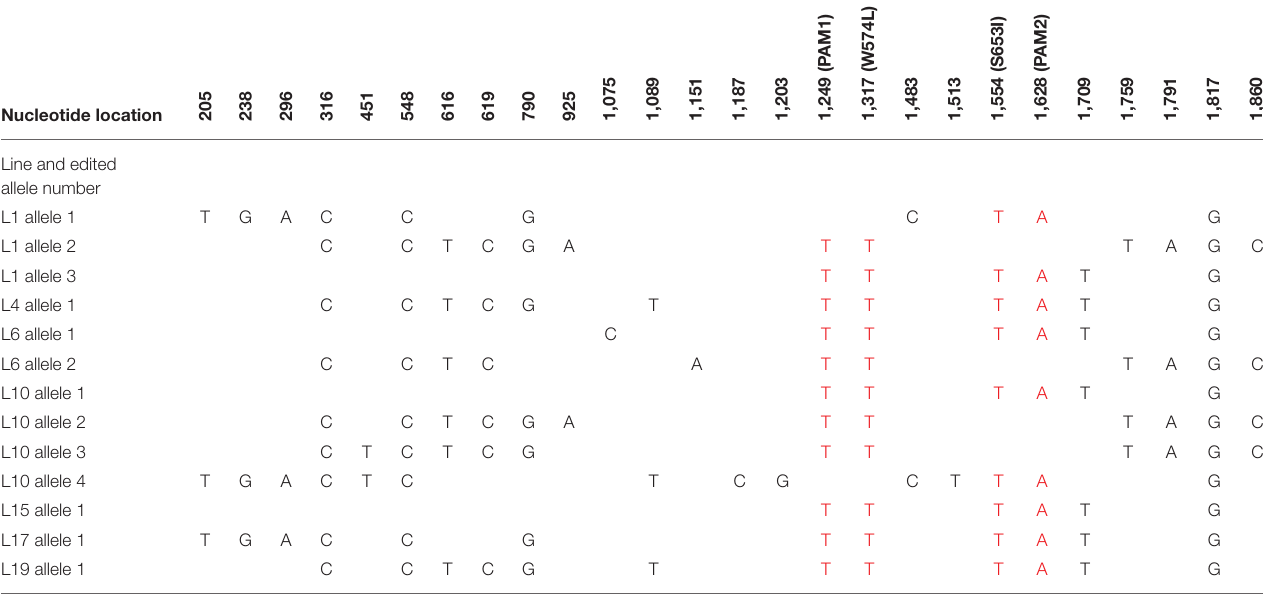
TABLE 3 | Naturally occurring SNPs distinguishing the different ALS alleles from the repair template in edited sugarcane ALS alleles.